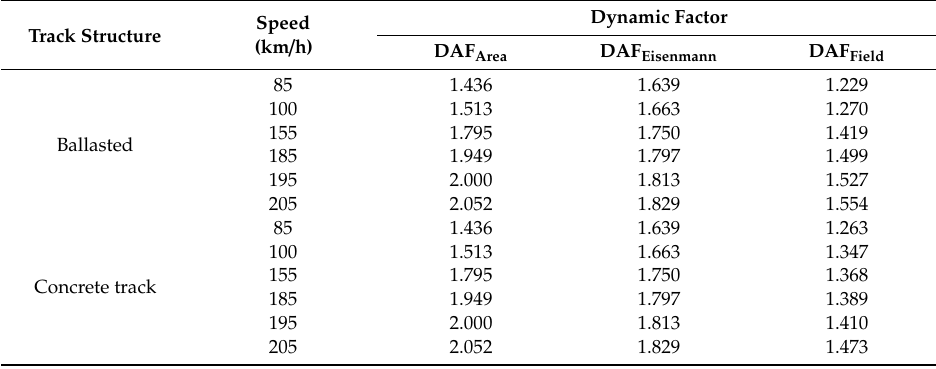
Table 15. Dynamic Factor Comparison of Ballasted and Concrete